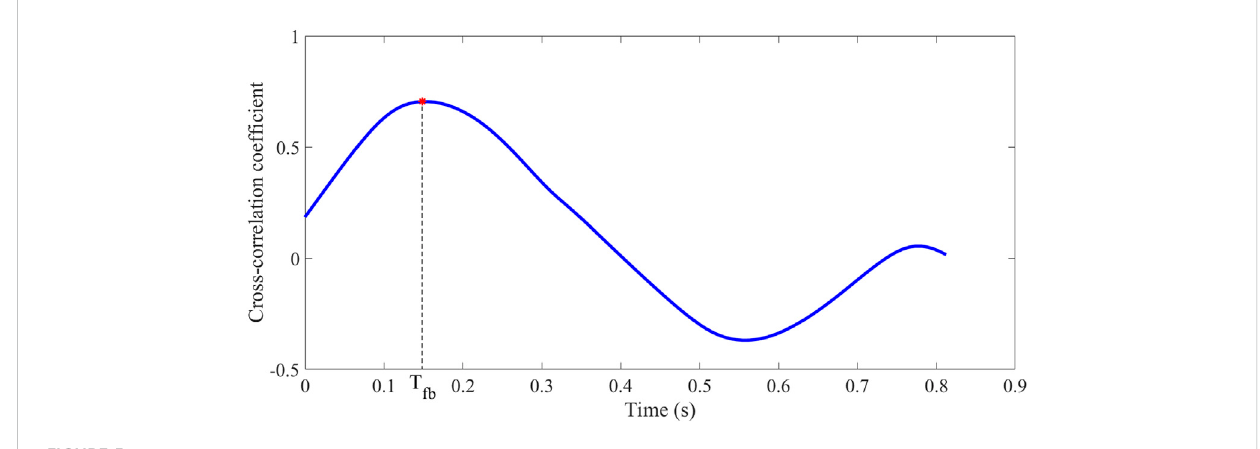
FIGURE 5 Calculation of T fb : cross-correlation between P f and P b